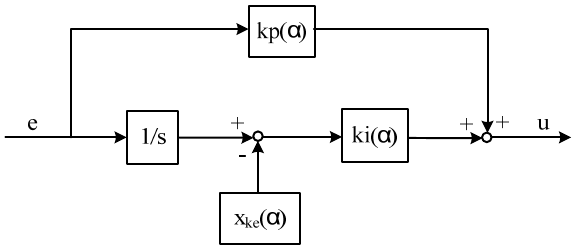
Figure 9. Modified PI gain scheduled controller.